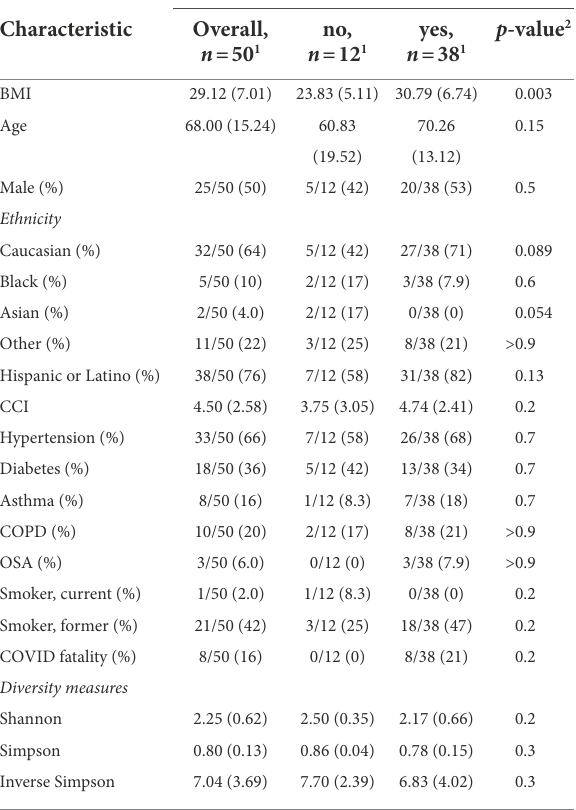
TABLE 1 Study population